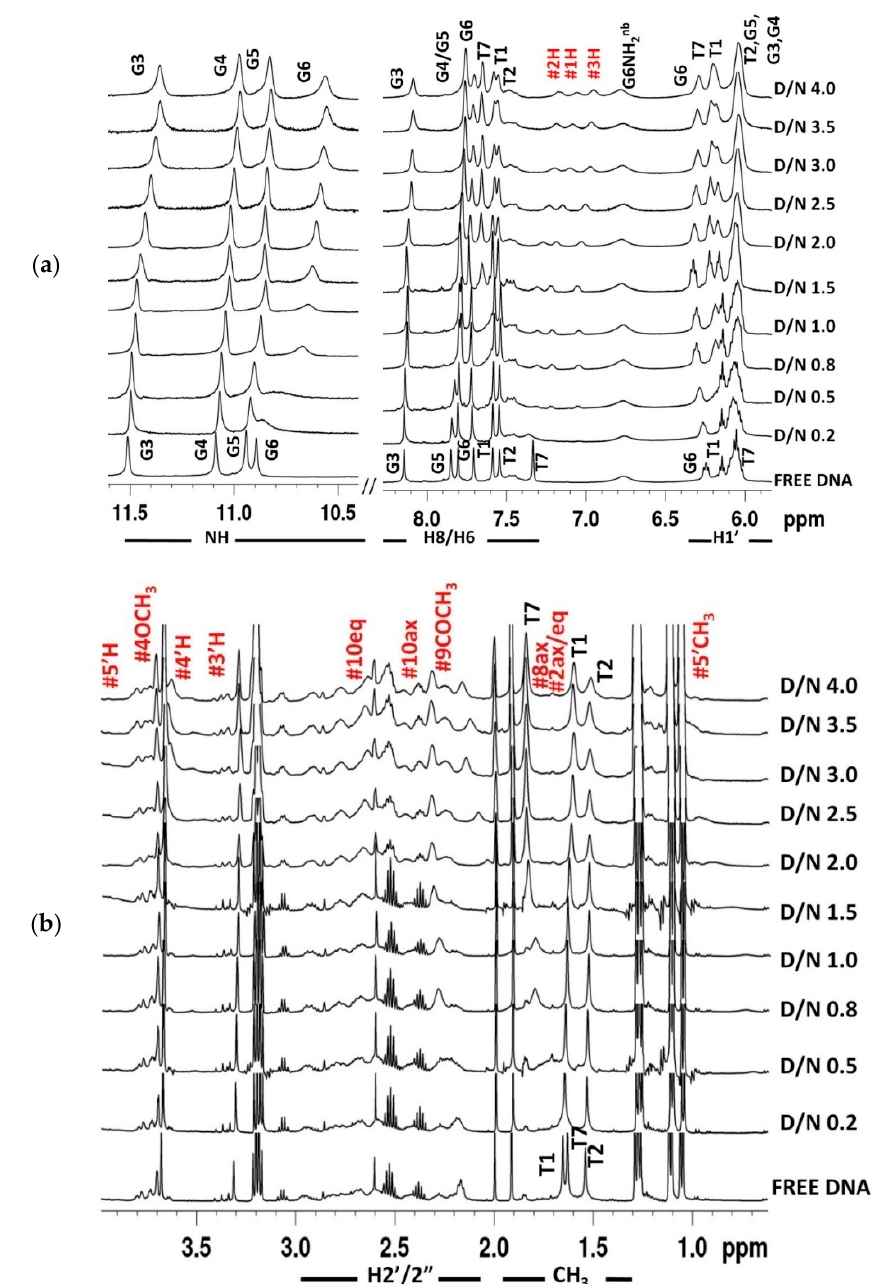
Figure 3. 1D 1 H NMR spectra of 1.16 mM of [d-(TTGGGGT)] 4 and its complex upon the progressive addition of daunomycin to DNA at different D/N ratios at 25 °C. ( a ) Imino, base, and sugar H1 ′ protons along with ring D aromatic protons 1H, 2H, and 3H of daunomycin; ( b ) Deoxyribose sugar H2 ′ /2 ′′ and methyl protons of thymine along with daunomycin protons 5 ′ H, 4OCH 3, 4 ′ H, 3 ′ H, 10eq, 10ax, 9COCH 3 , 8ax, 2ax, 2eq, and 5 ′ CH 3 at 25 °C. Symbol # denotes daunomycin protons.